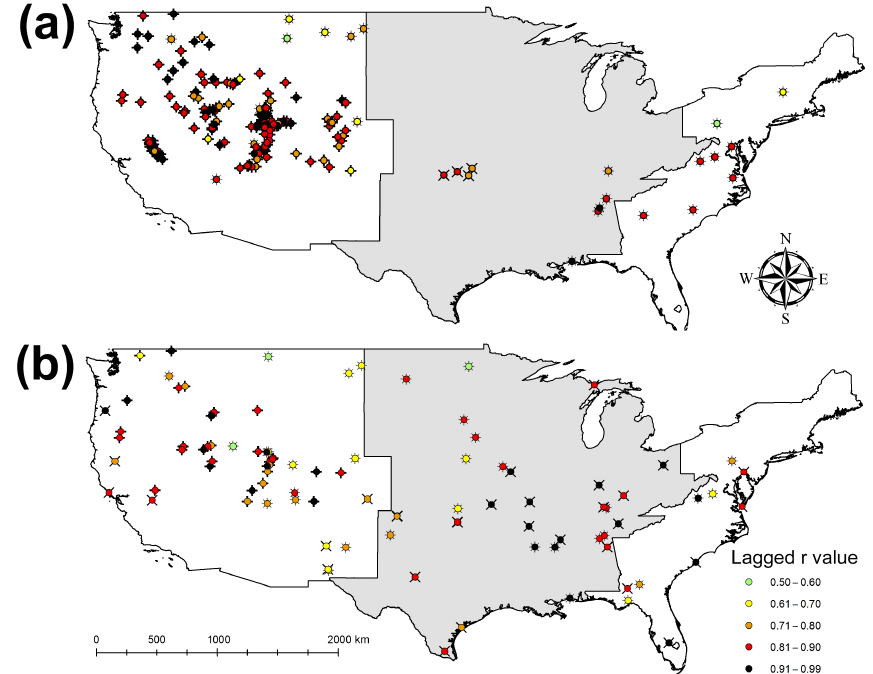
Figure 2. Locality map of examined in situ stations (ARM: X; SCAN: ∗ ; SNOTEL: + ) with (a) era 4 and (b) era 5. During era 5, X represents USCRN instead of ARM stations. The gray area represents the central CONUS, whereas white indicates the eastern and western regions of